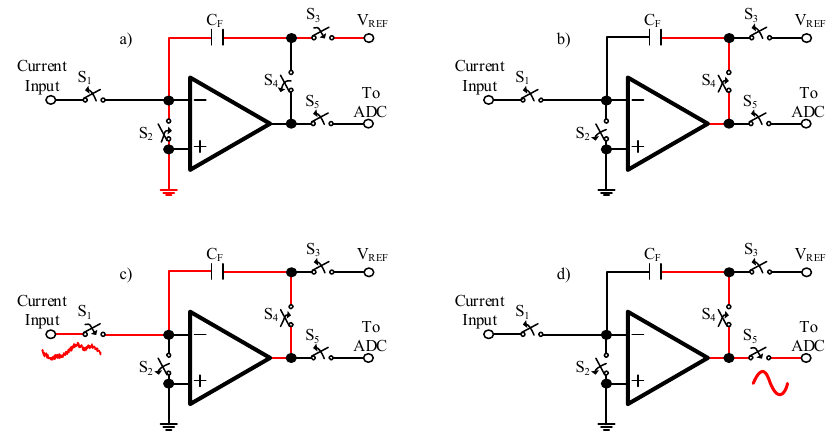
Figure A2. Schematics of the DDC switched-capacitor integrator configurations. ( a ) Reset configuration :